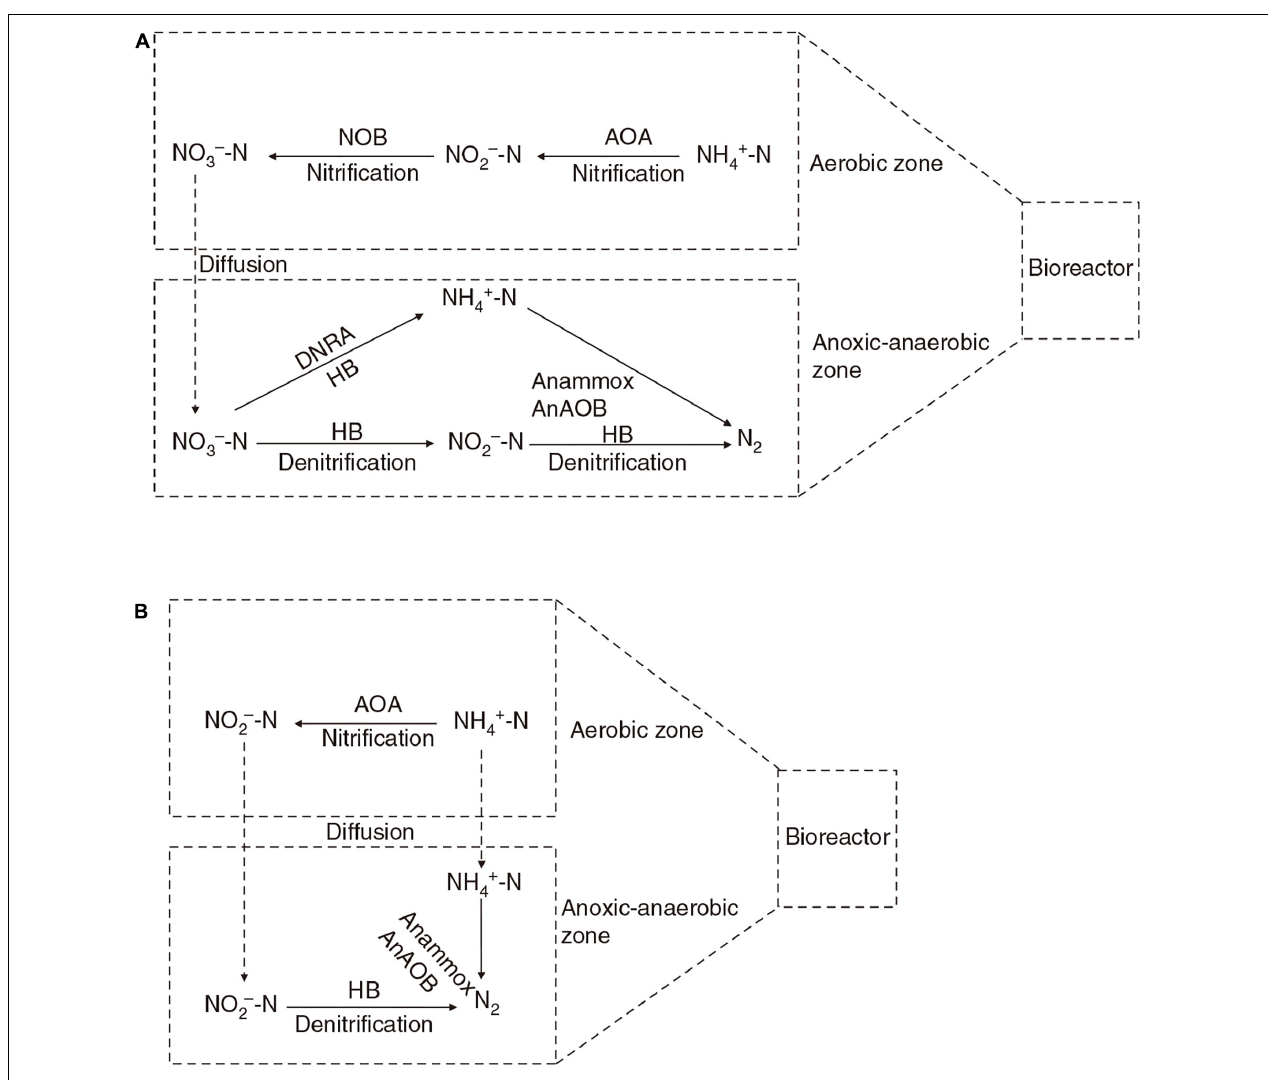
FIGURE 1 | Cooperative working mechanism of AOA and AnAOB in bioreactor. AOA, ammonia-oxidizing archaea; NOB, nitrite-oxidizing bacteria; AnAOB, anaerobic ammonia-oxidizing bacteria; HB, heterotrophic denitrifying bacteria; DNRA, dissimilatory nitrate reduction to ammonium process. Solid arrows represent different nitrogen cycling processes, and the dashed arrow represents diffusion in bioreactor. AnAOB use nitrite and ammonia generated by heterotrophic denitrification and dissimilatory nitrate reduction process in the anoxic–anaerobic zone of biofilm (A) , where the nitrate concentration is high but ammonia and nitrite are scarce. Alternatively, AnAOB can directly use nitrite produced by AOA and ammonia generated by heterotrophic ammonification, where nitrite-oxidizing bacteria are inhibited (B)